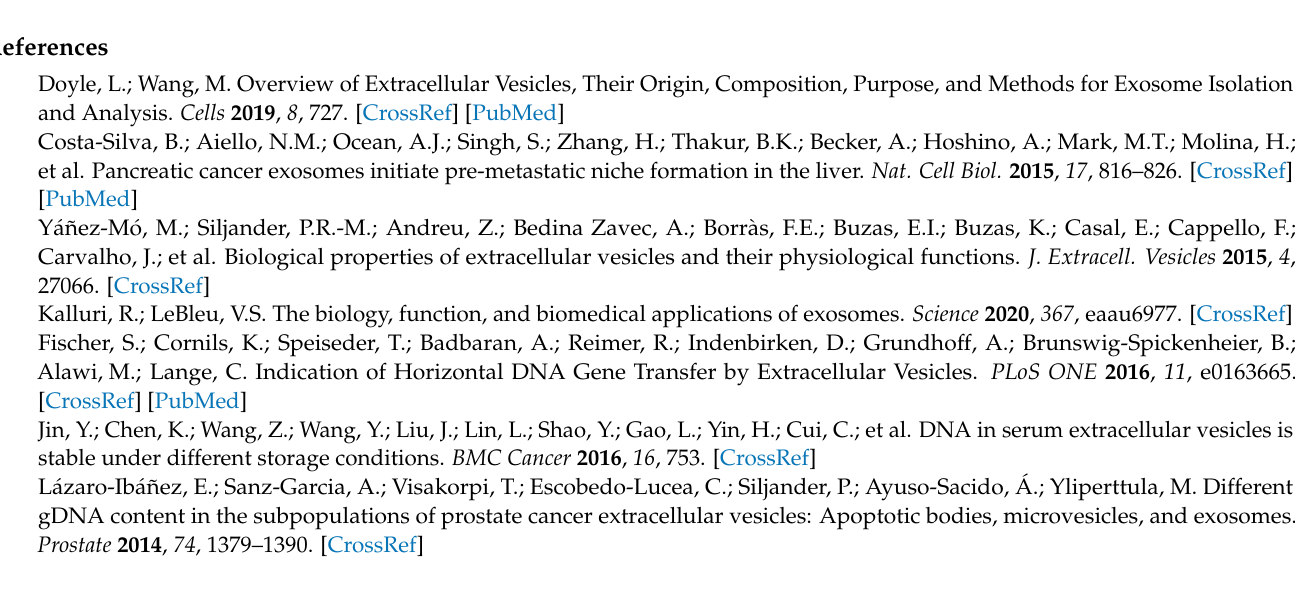
particle; Table S1: Number of cells seeded at the initiation of culture for conditioning; Table S2: Cell lines used as positive and negative controls for TaqMan; Table S3: The clinical characteristics of patients; Table S4: Technical aspects of patients’ blood sample collection and processing; Table S5: List of primary and secondary antibodies used for Western blotting; Table S6: Primers and probes sequences used in TaqMan; Table S7: Customized panel for NGS; Table S8: Comparison of ng